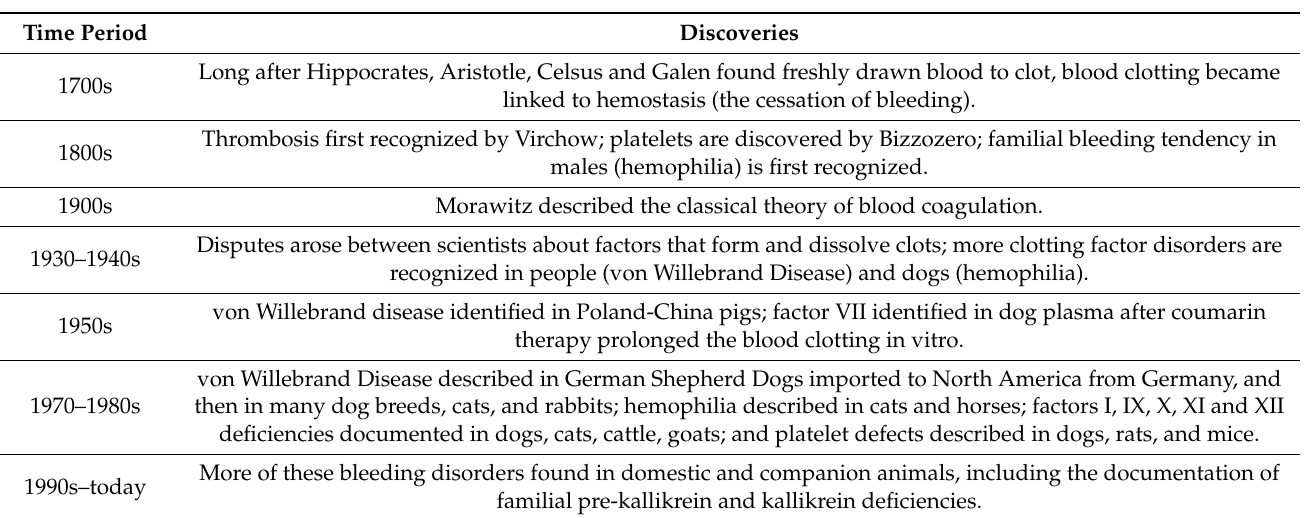
Table 2. Scientific history of blood coagulation